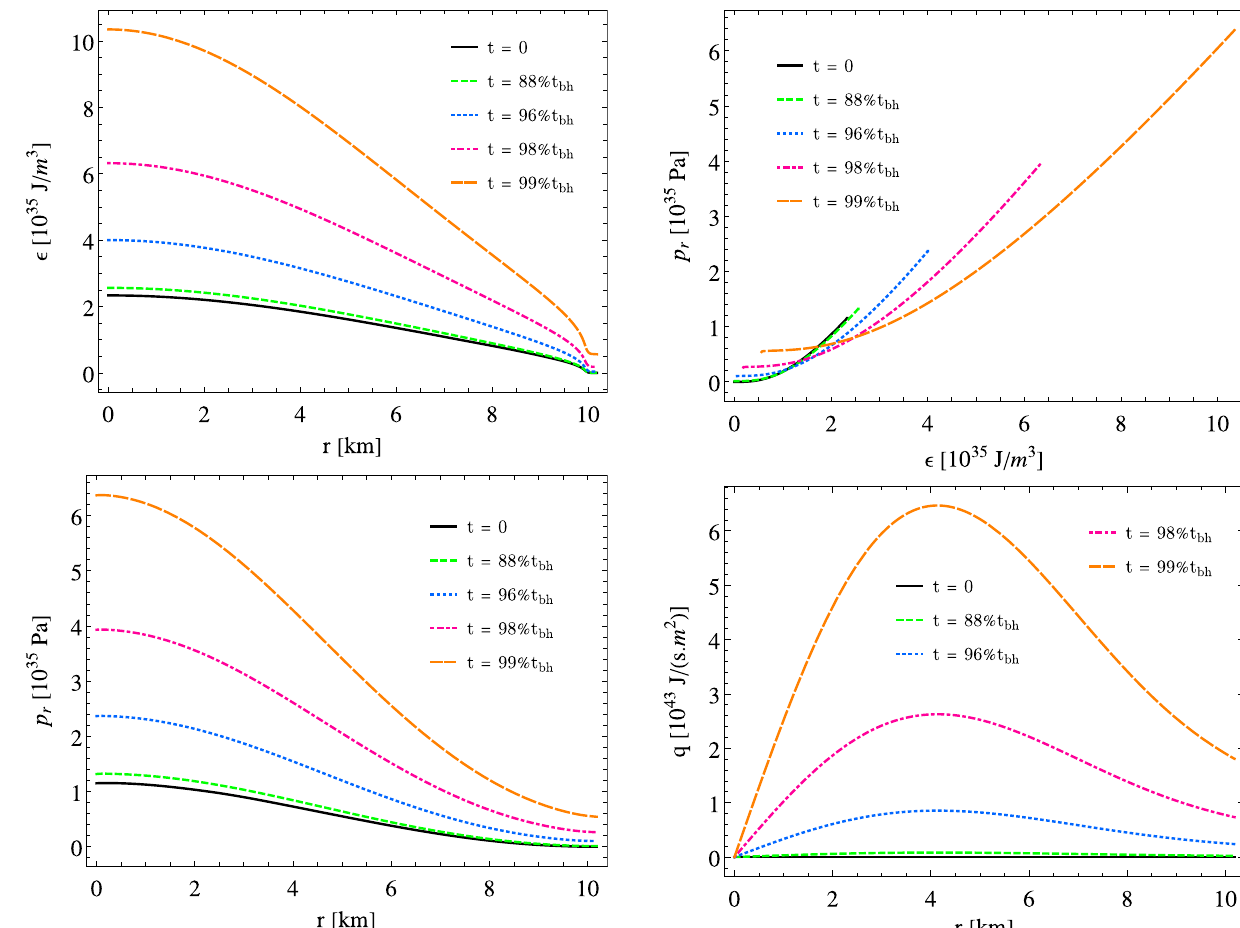
Fig. 6 Upperpanel:EvolutionoftheEoS p r = p r (ε) duringthegravi- tationalcollapse.Lowerpanel:Heatfluxasafunctionoftheradialcoor- dinate at different times. The central density and anisotropy parameter have the same values as in Fig.